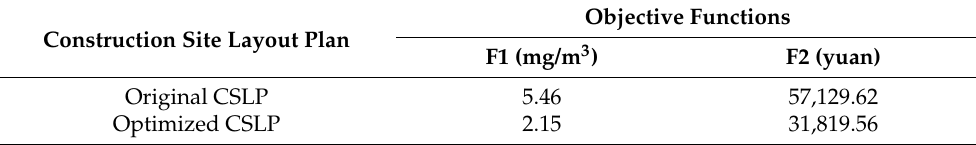
Figure 6. Original construction site layout plan. Table 4. Comparison of the construction dust impact and total transportation cost. Construction Site Layout